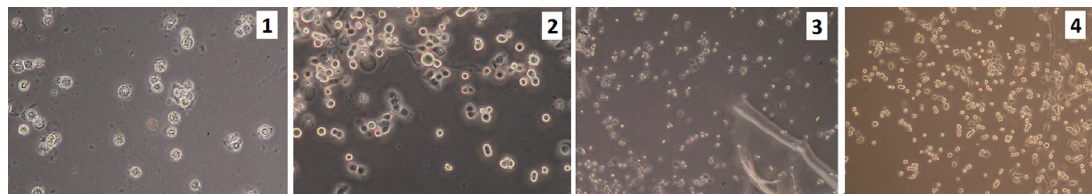
Figure 14. Unsterilized scaffolds coated with fibronectin (100 ng/1 mL), rinsed in the high volume of PBS containing antibiotics; 3rd of the cell culture . (sample 1—chitosan crosslinked with adipic and malonic acid; sample 2—chitosan crosslinked with adipic and L -glutamic acid; sample 3—chitosan crosslinked with adipic, L -glutamic and malonic acid; sample 4—chitosan crosslinked with adipic and levulinic).